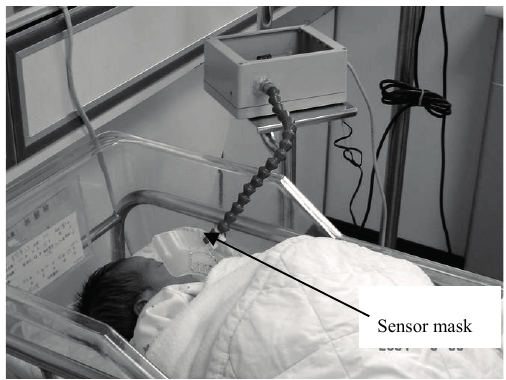
Figure 8. The adjustable sensor mask with thermo-sensors [36]. Copyright © 2015 World Scientific Publishing